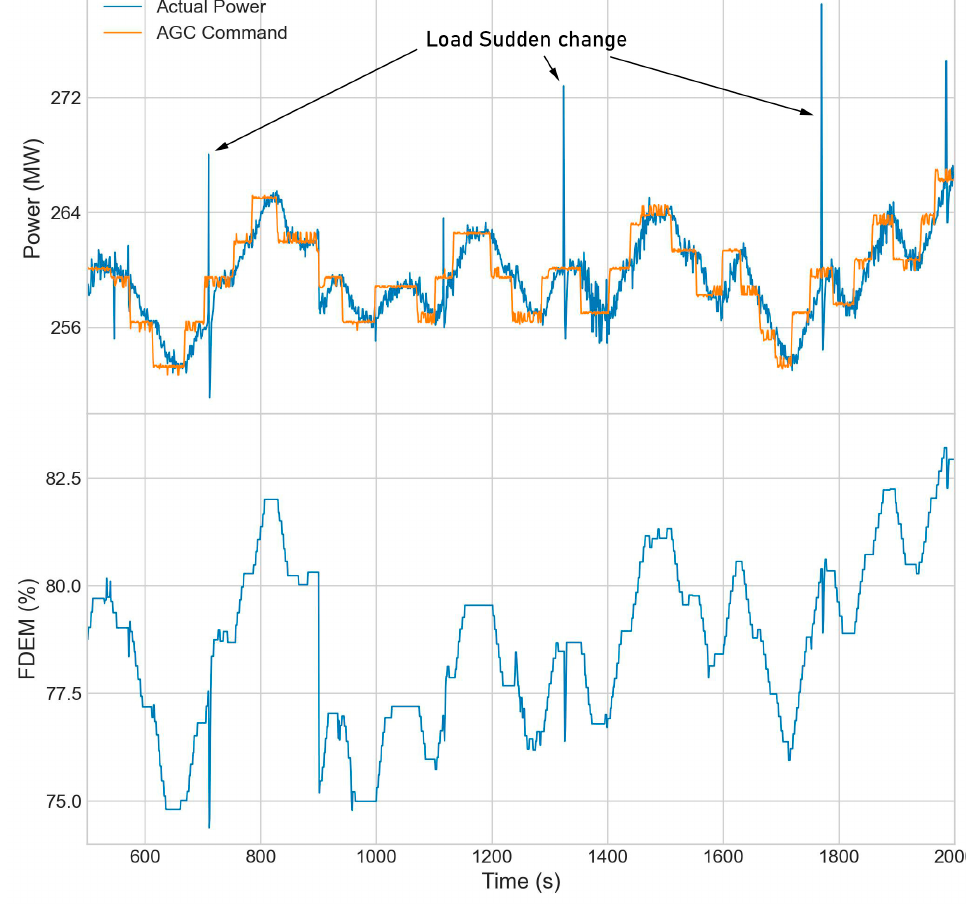
Figure 1. Pulsing load mutation.